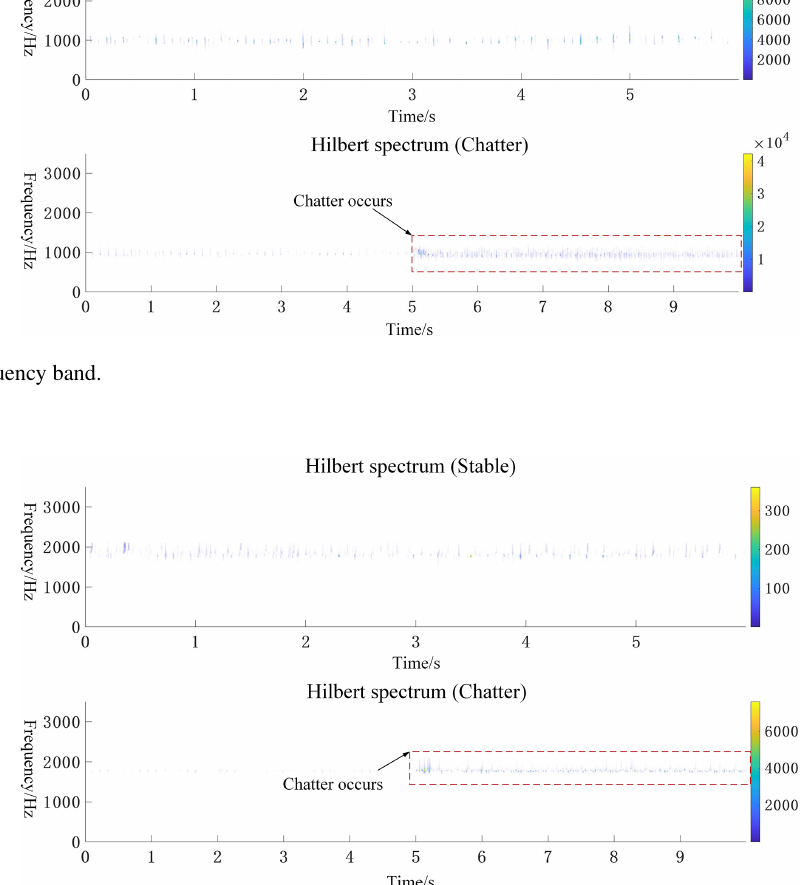
Figure 18. The d 4 frequency band.